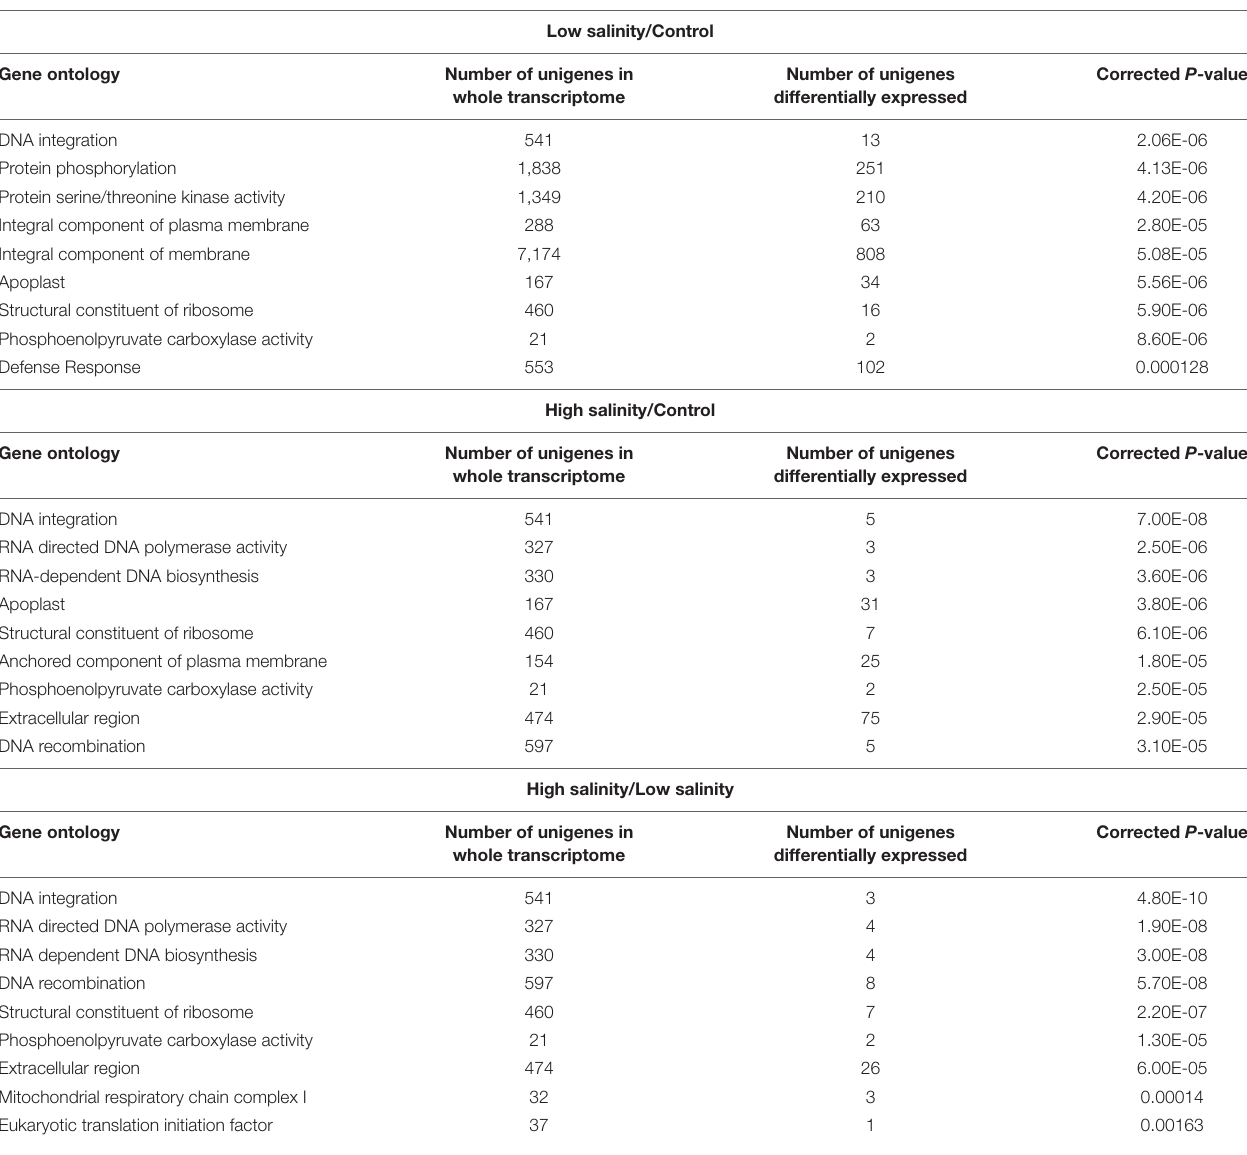
TABLE 3 | GO classification of significantly enriched DEGs by the topGO